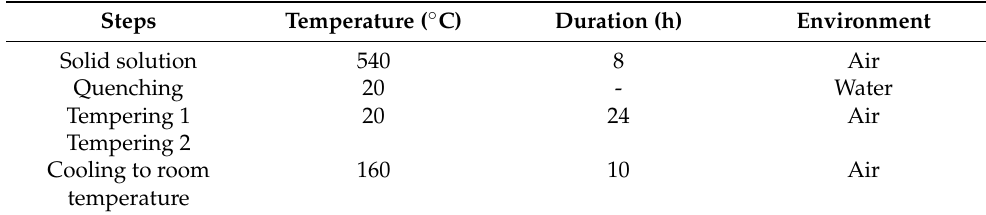
Table 2. T6 heat-treatment conditions.